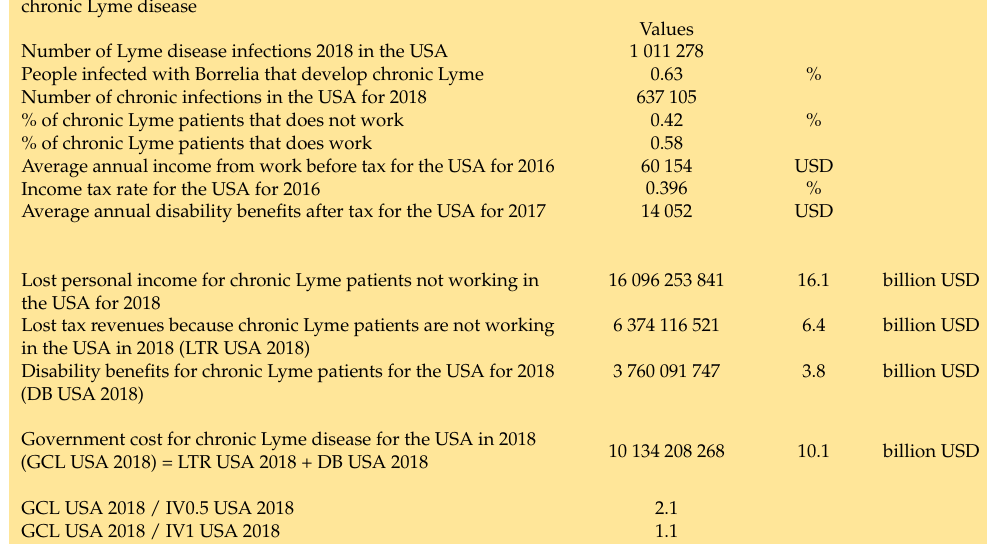
Table 13. Government cost for chronic Lyme disease for the USA for 2018 if governments do not finance IV treatment with antibiotics for chronic Lyme disease.